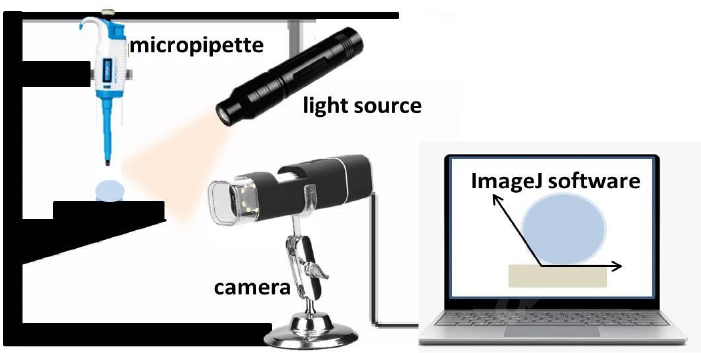
Figure 2. Experimental setup for measuring the water contact angle (WCA) of PLA samples.